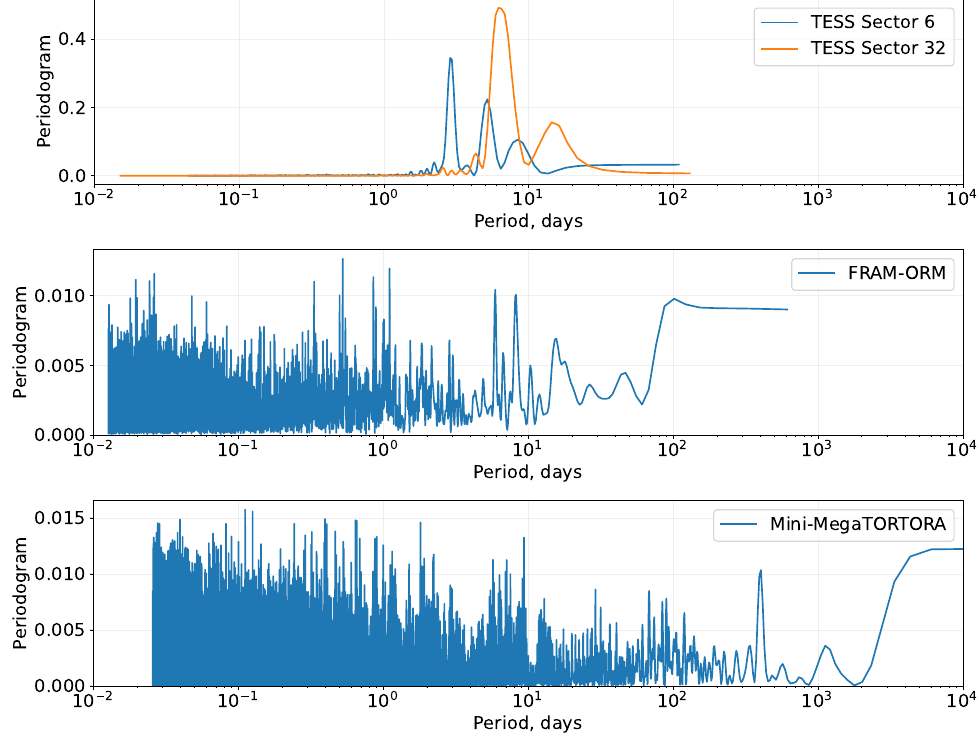
Figure 9. Lomb–Scargle periodograms of HD36030 light curves from TESS , FRAM-ORM, and Mini- MegaTORTORA. For TESS , the data for both sectors are shown in the upper panel . The peaks there supposedly correspond to uncorrected instrumental effects in the light curves. The middle panel shows the multiband periodogram [58] for the FRAM-ORM light curve, and the lower panel shows the periodogram of Mini-MegaTORTORA data. There are no high-significance peaks visible in both of the latter